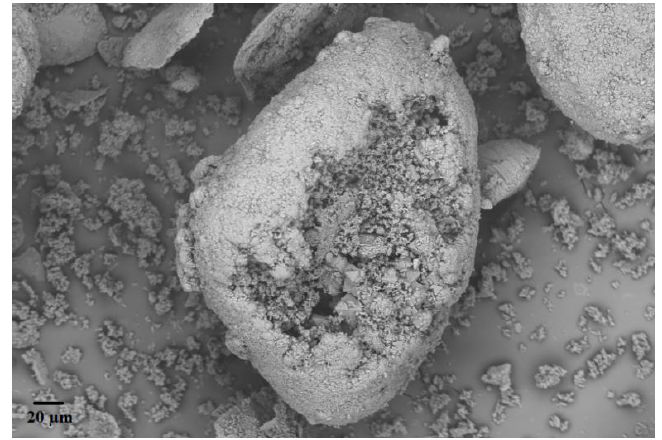
Figure 10. Micrograph of the leaching residue at 123 °C with 15% v/v HF.